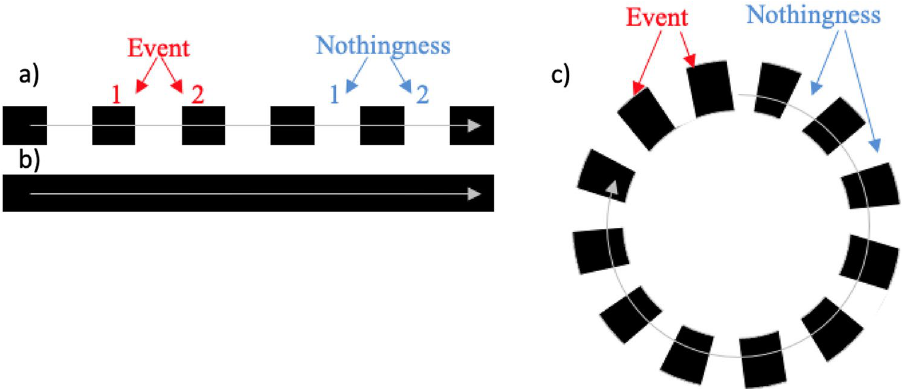
Figure 1. According to Bachelard, an event or an instant is something that happens between nothingness 1 and nothingness 2. By analogy, nothingness happens between two instants (i.e., linear ( a ) and rotating throbbers ( c